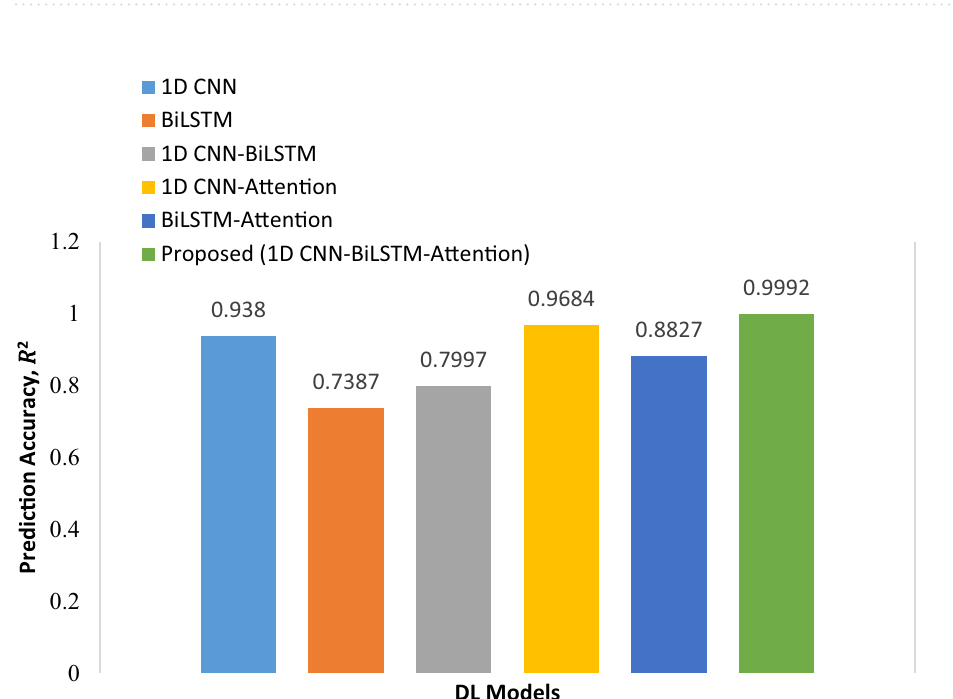
Figure 7. The prediction accuracy of different models on the validation